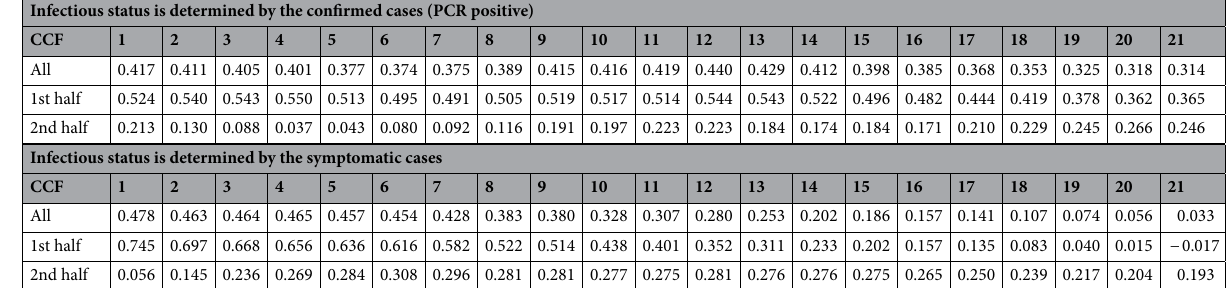
Table 1. CCF of 1 ~ 20 days lags for All (2020/3/1 ~ 2020/12/31), 1st half (2020/3/1 ~ 2020/6/30), and 2nd half (2020/7/1 ~ 2020/12/31). LocationMind xPop © LocationMind